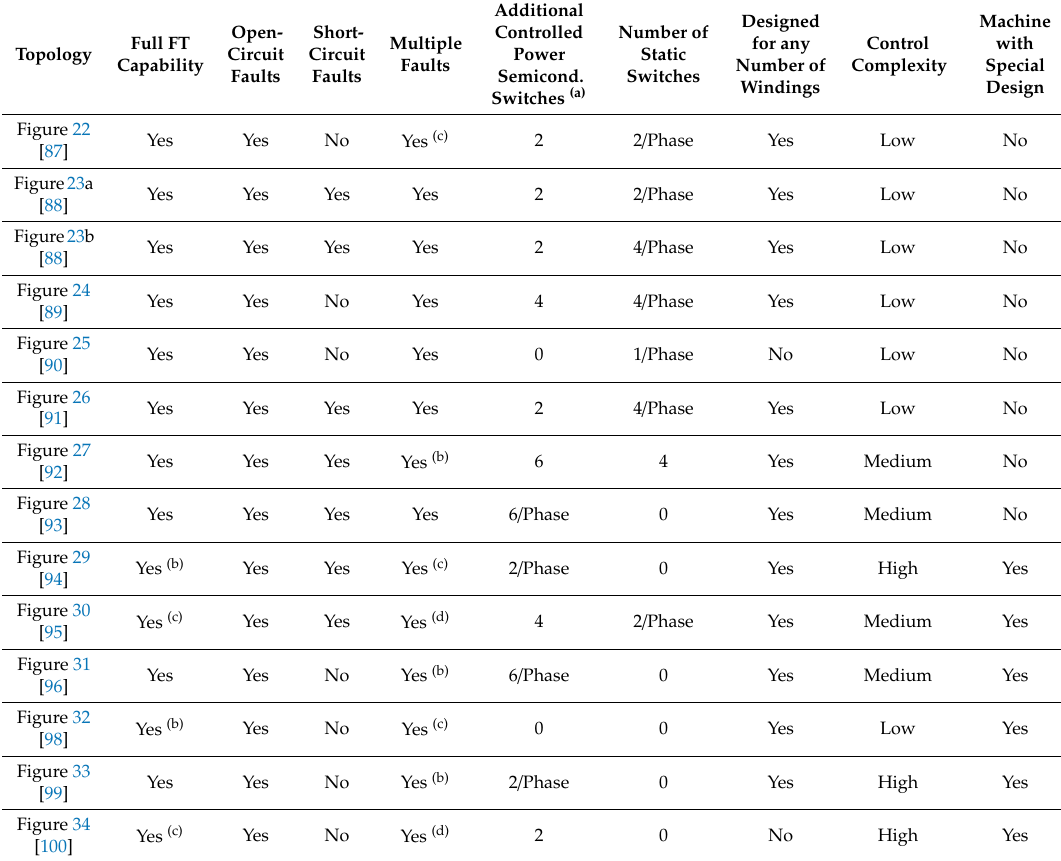
Table 4. Comparative summary of the fault-tolerant (FT)